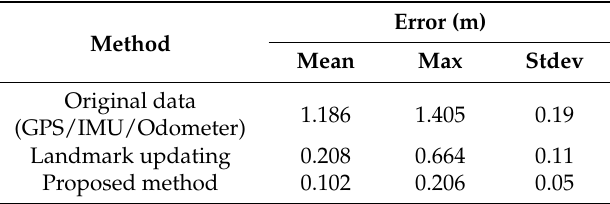
Figure 24. The 2D error of survey No. 6 in the original data, after the landmark update, and after the proposed method. Table 3. Evaluation result of survey No. 6.